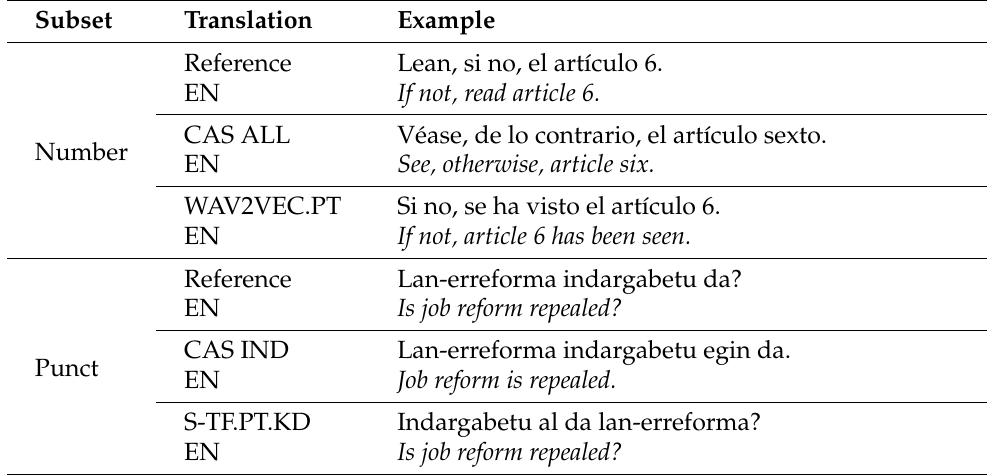
Table 16. Examples of diverging translations on specific phenomena, with English